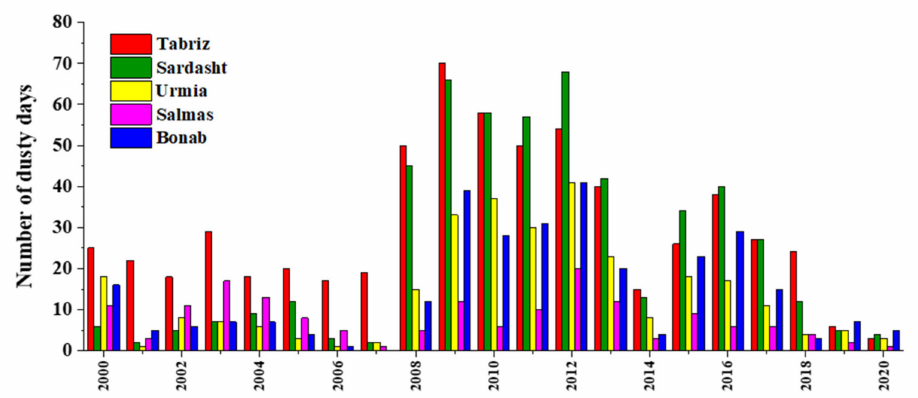
Figure 6. The total annual number of dusty days at the weather stations Tabriz, Sardasht, Urmia, Salmas, and Bonab from 2000 to 2020. Courtesy of Iran Meteorological Organization.